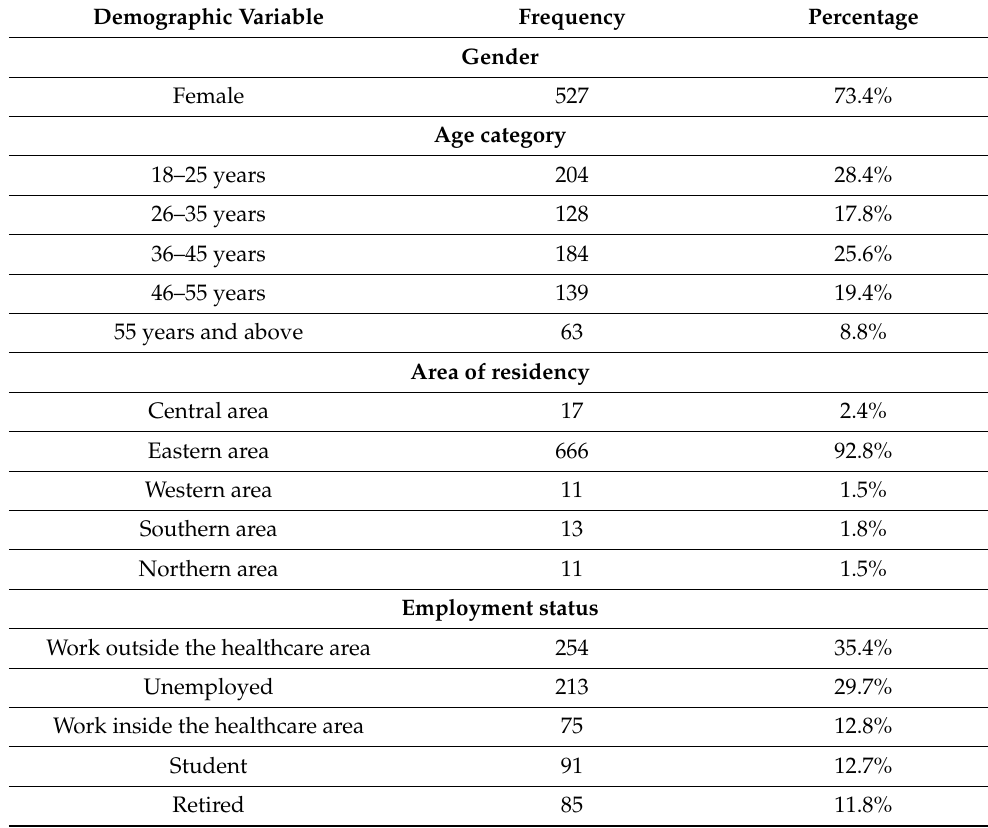
Table 1. Demographic characteristics of the study